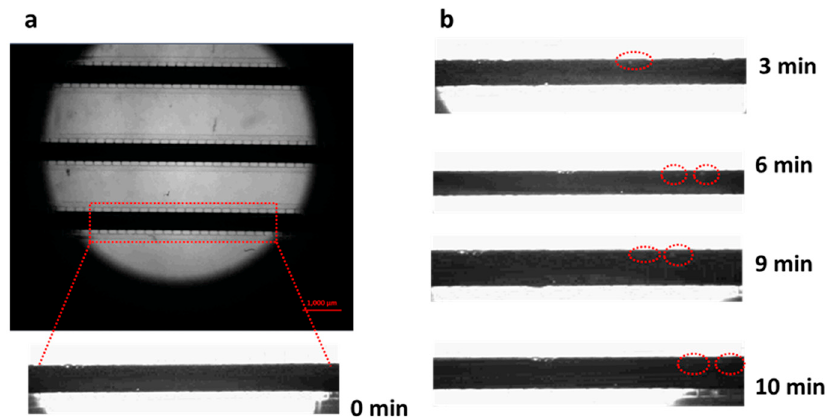
Figure 5. The growth of voids in microchannel with ventilating gaps. ( a ) depicts the morphology of the microelectrode without heating. The inset shows a segment of electrode at the bottom. ( b ) records the morphological changes after working 3, 6, 9 and 10 min of heating. With the increase of temperature, the voids (red dot ellipse) started to birth but not expend.